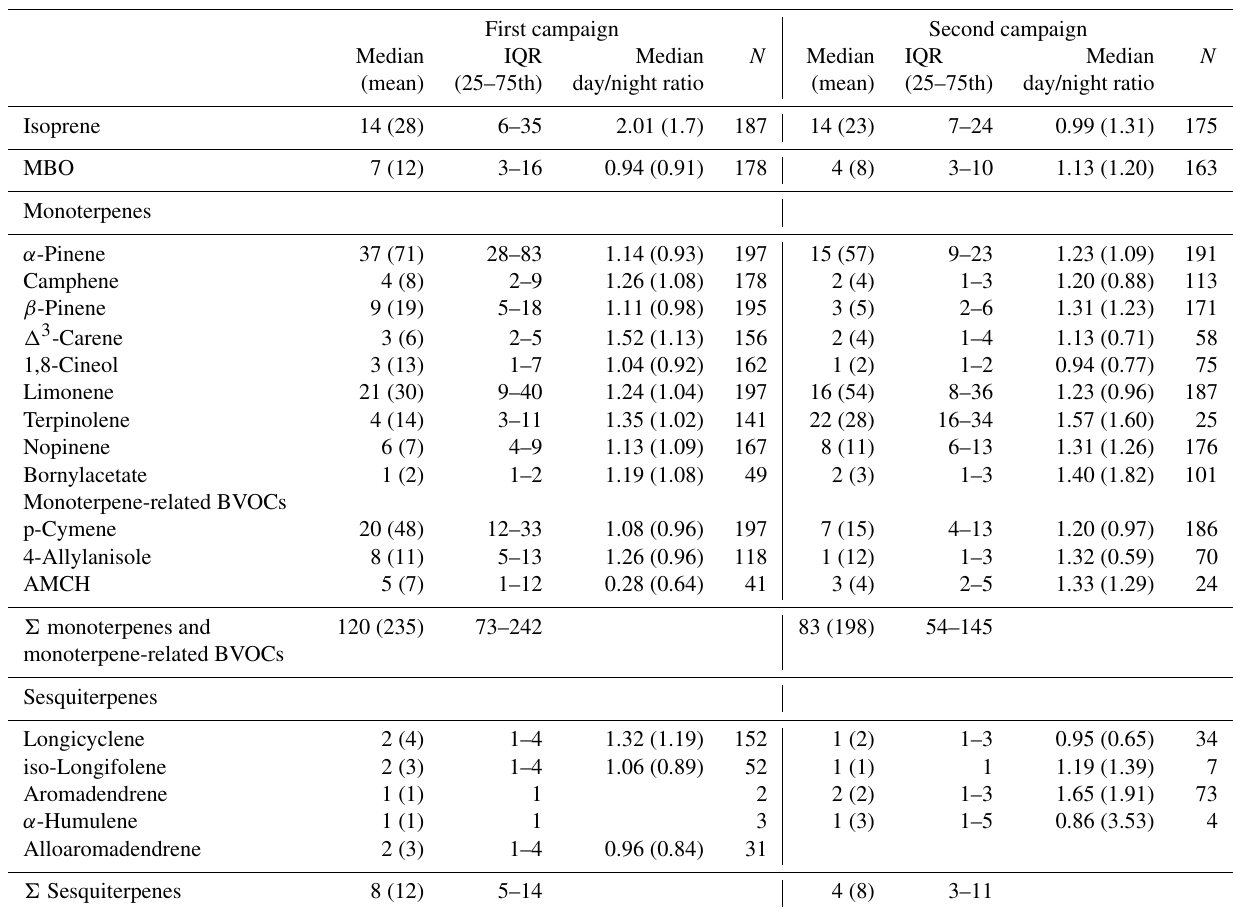
Table 2. The ambient BVOC concentration for the two campaigns measured at